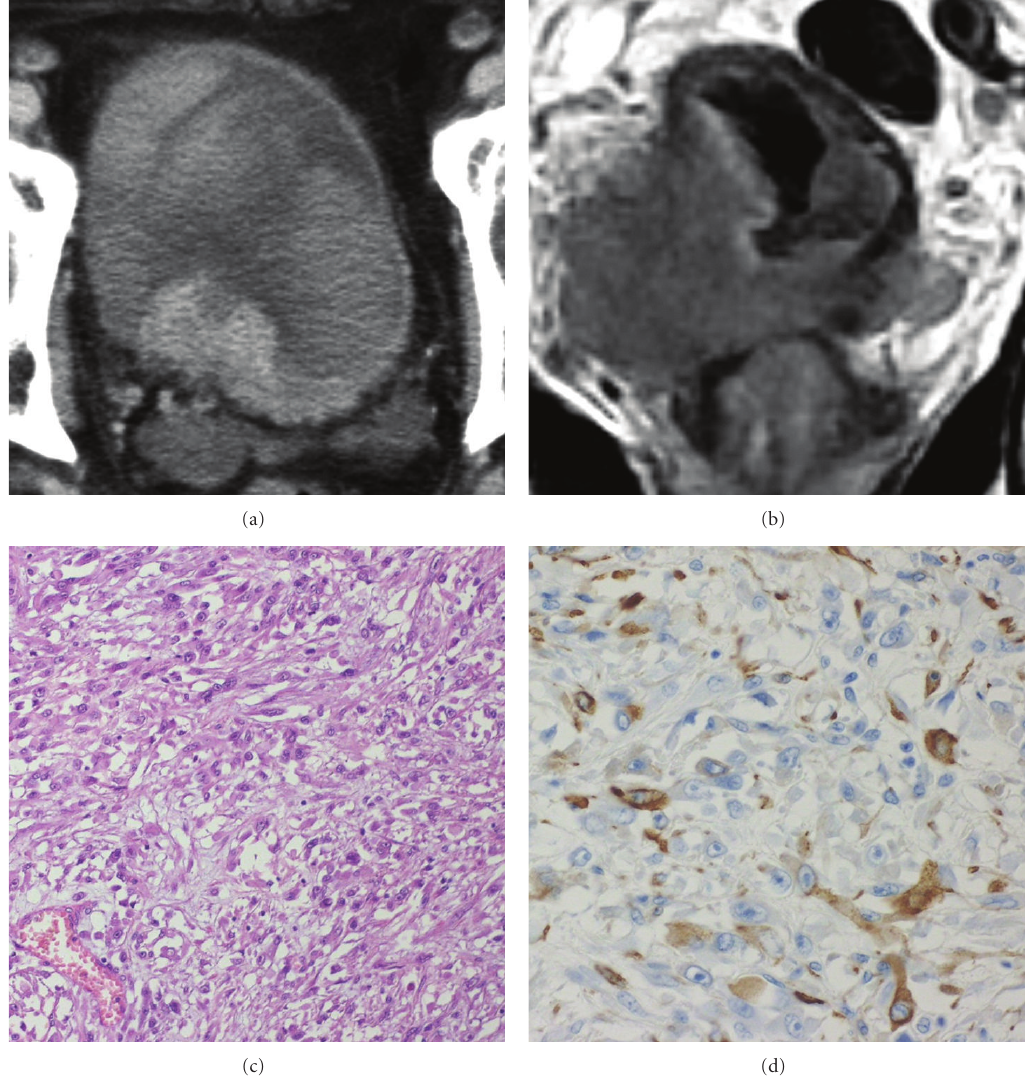
Figure 1: (a) Computed tomography shows a large bladder tumor measuring 4cm × 3 cm and right hydronephrosis. (b) Magnetic resonance imaging shows extravesical invasion of the tumors. (c) Hematoxylin-eosin stain shows leiomyosarcoma of the bladder tumor. (d) Immunohistochemical staining of the bladder tumor is positive for α -smooth muscle